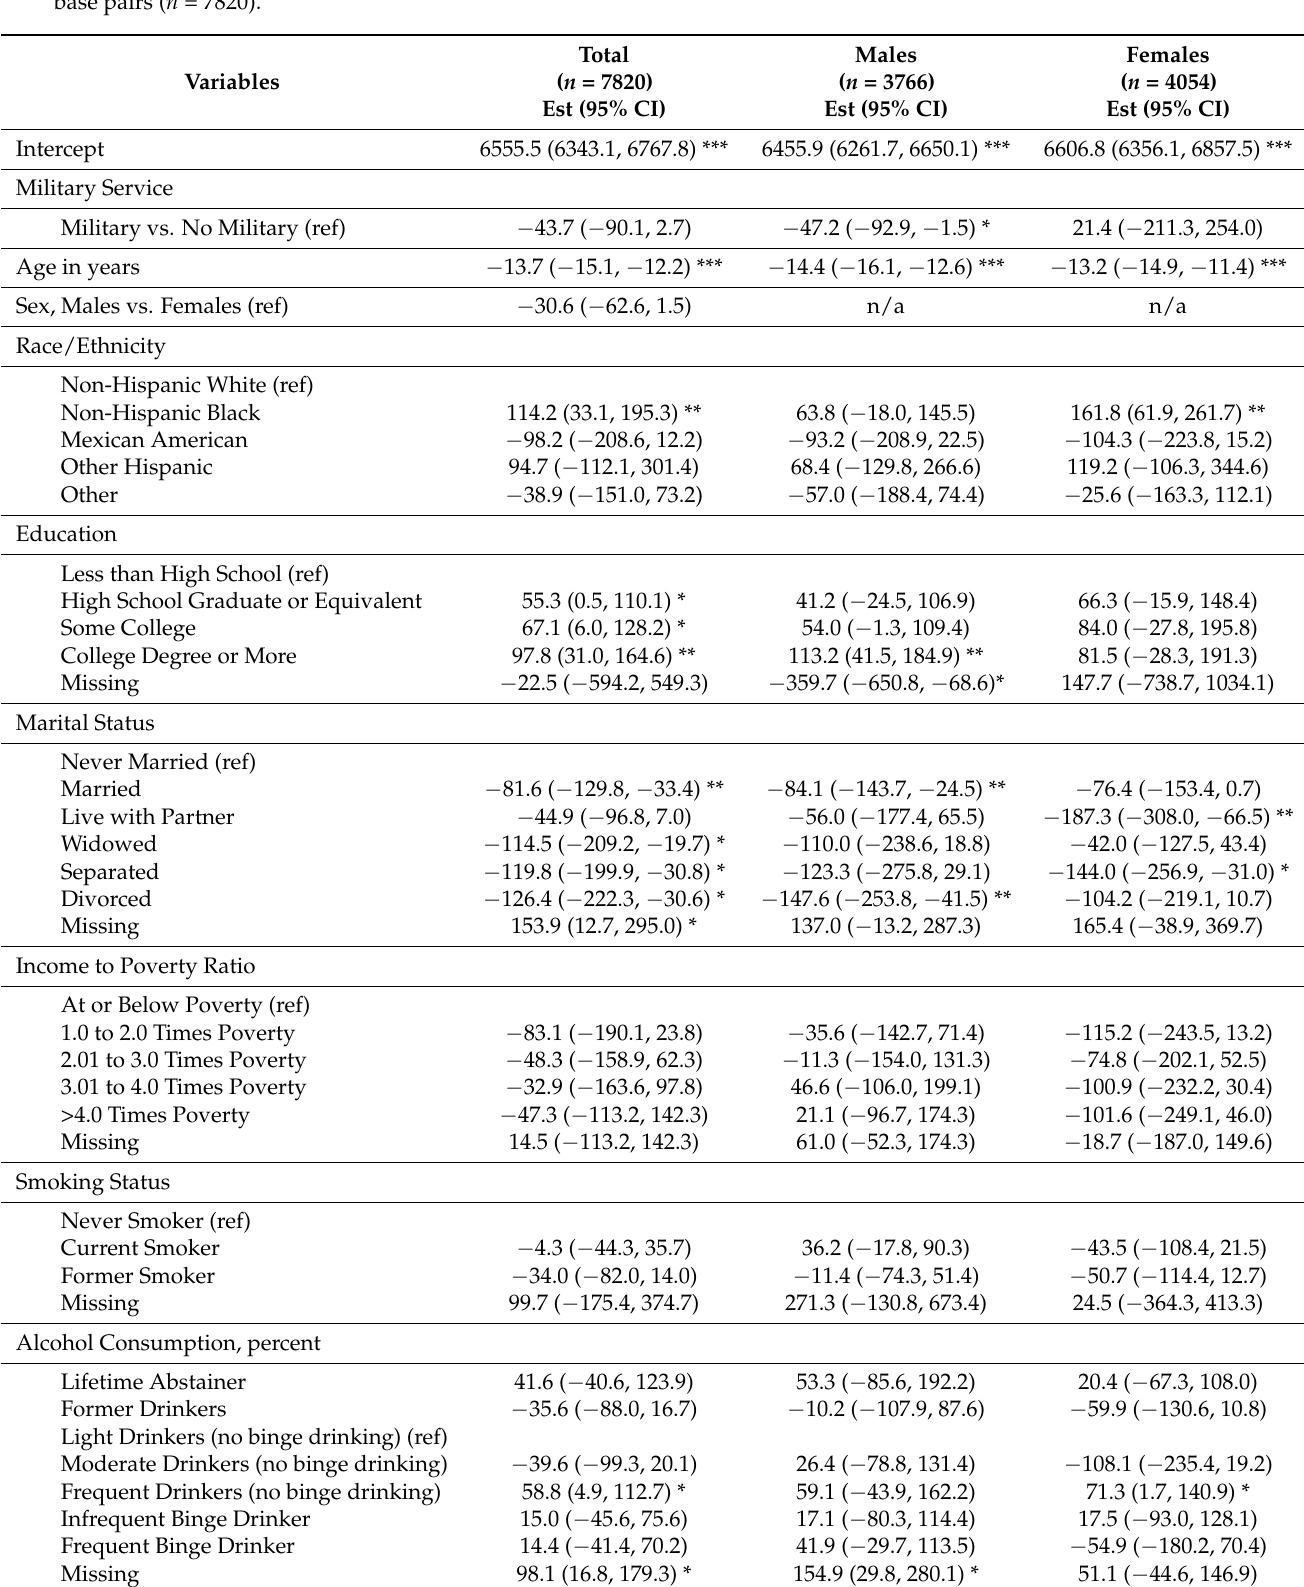
Table 3. Weighted results of total sample and sex-stratified, multivariable linear regression analyses of telomere length in base pairs ( n =